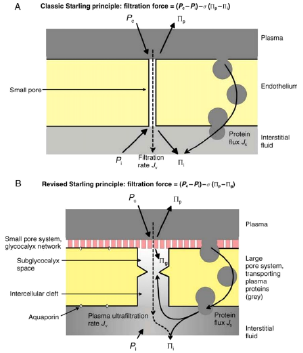
Figure 1. A comparison of the classic and revised views of the Starling Principles showing the forces acting on the endothelial semi-permeable membrane [7]. ( A ) The classic view showing the endothelium as a semipermeable layer. ( B ) The revised view showing the glycocalyx as the semipermeable layer; grey shading represents the protein concentration. Jv is the fluid filtration rate, P c is the capillary hydrostatic pressure, Pi is the interstitial hydrostatic pressure, σ is the reflection coefficient, π c is the capillary oncotic pressure and π i is the interstitial oncotic pressure. Republished with permission of Elsevier, from [7] permission conveyed through Copyright Clearance Center,